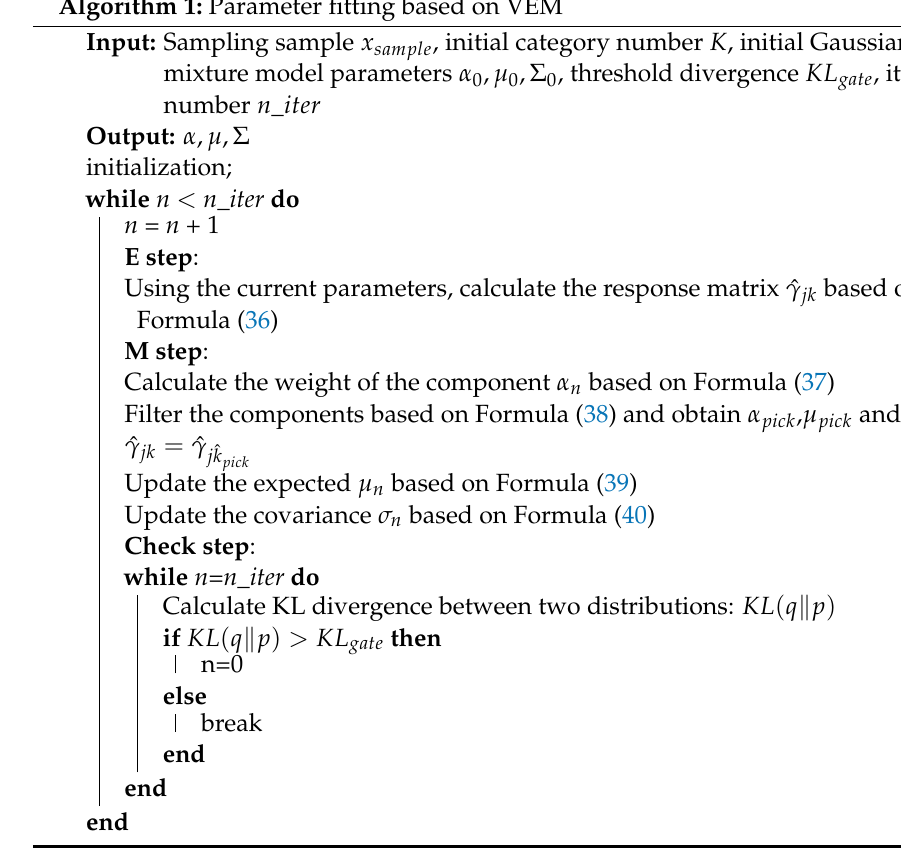
Algorithm 1: Parameter fitting based on